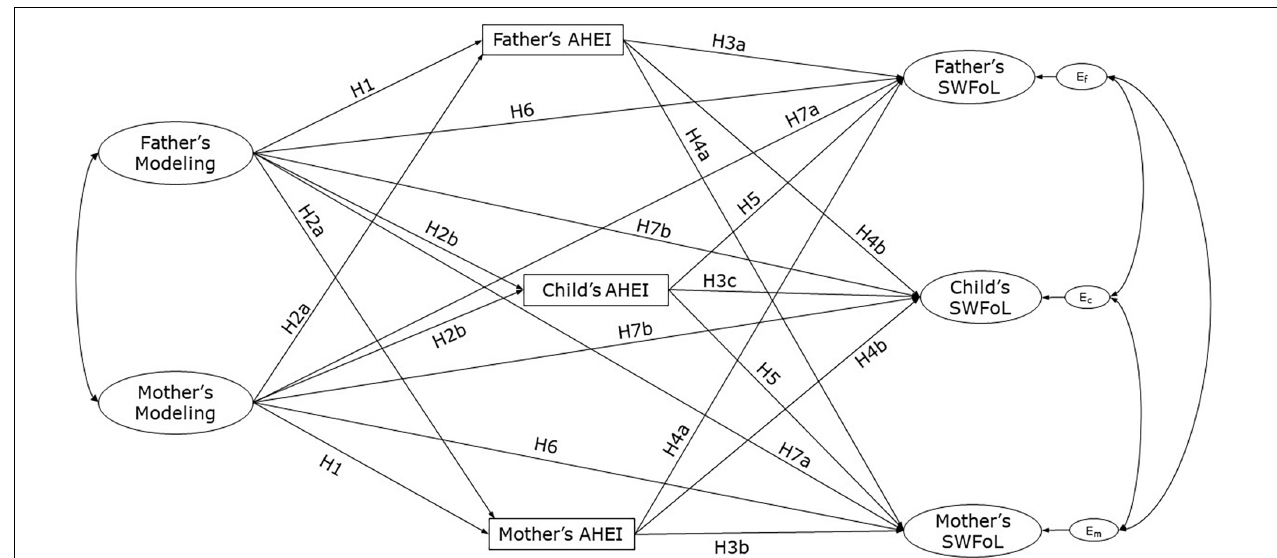
FIGURE 2 | Conceptual model of the proposed actor and partner effects of both parent’s modeling on the three family members’ diet quality (measured by the Adapted Healthy Eating Index, AHEI) and Satisfaction with Food-related Life (SWFoL) in dual-earner parents with adolescent children. Ef, Ec, and Em, residual errors on SWFoL for the fathers, mothers and their adolescent children, respectively. The indirect effects of AHEI (H8) were not shown in the conceptual path diagram to avoid cluttering the